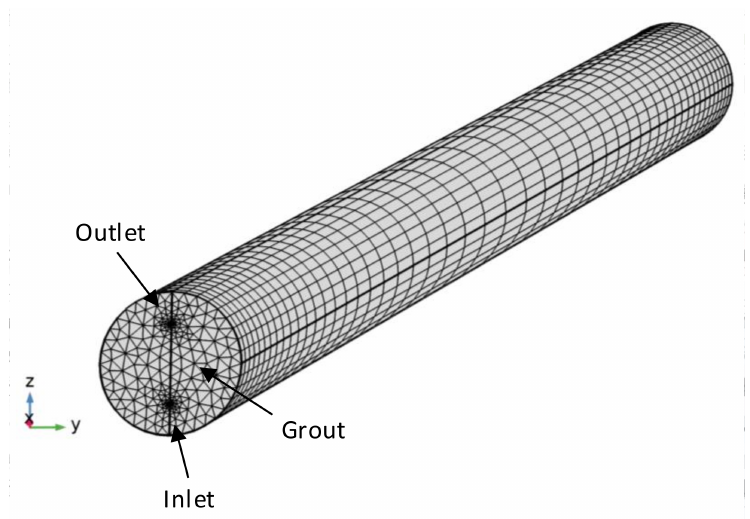
Figure 6. Swept finite element mesh used for the meshing of the single U-tube BHE in the HTiP